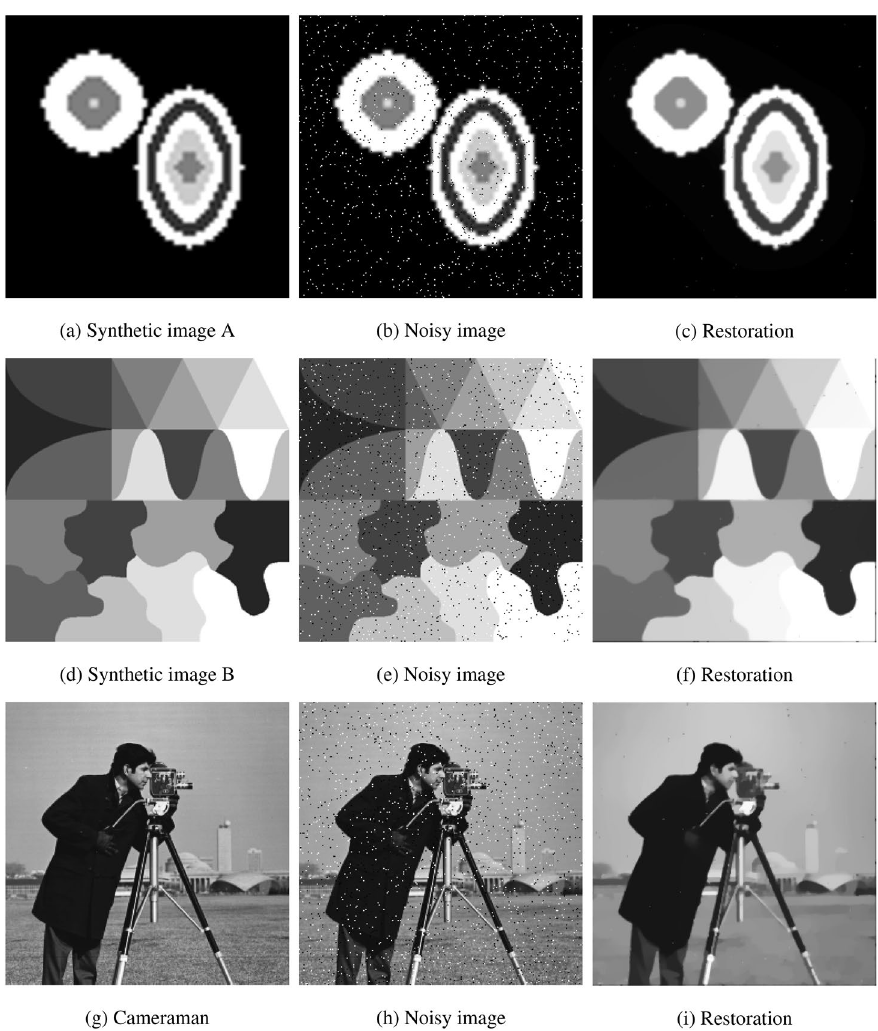
Figure 2. The denoising results of the proposed